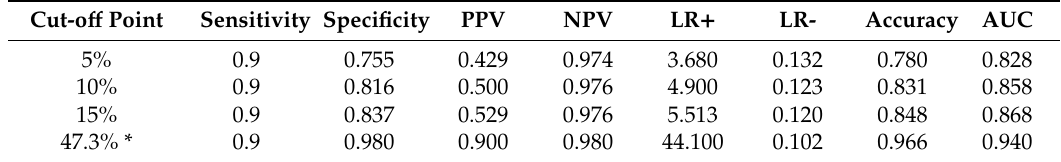
Table 3. Diagnostic performance of the IOTA (international ovarian tumor analysis)-ADNEX model at each cut-o ff point of overall malignancy